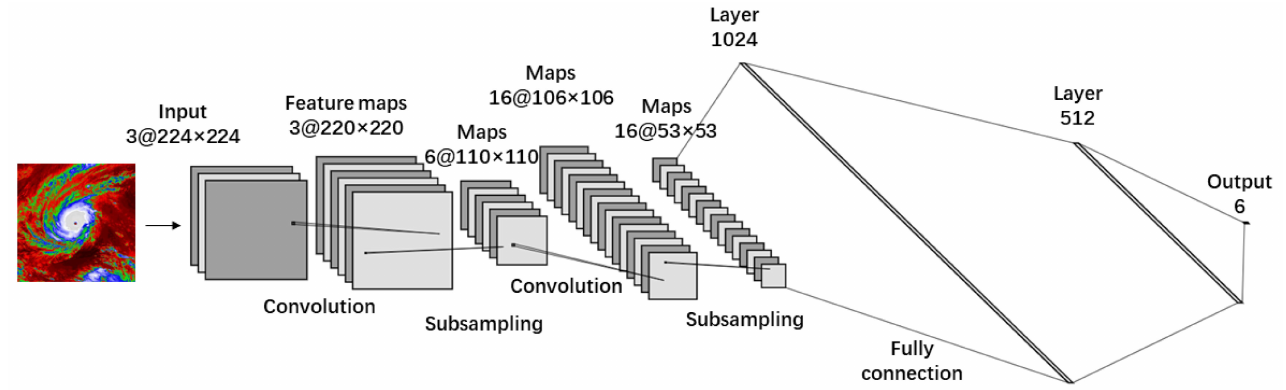
Figure A1. The overall structure of the LeNet-5